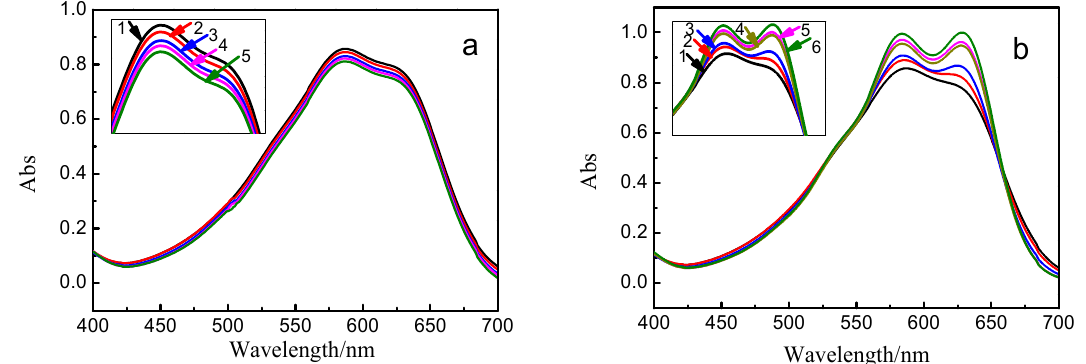
Figure 6. UV-vis spectra of reactive blue 19 (0.16 mmol/L) solution in the presence of AEO-3 with different concentrations. ( a ) [AEO-3] = (1) 0, (2) 0.014, (3) 0.027, (4) 0.045 and (5) 0.084 mmol/L. ( b ) [AEO-3] = (1) 0, (2) 0.14, (3) 0.56, (4) 1.60, (5) 4.60, and (6) 8.93 mmol/L. (Insert images were the enlarge part of the peak area of spectra).